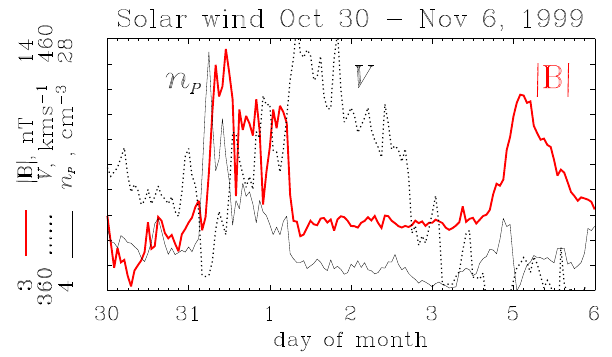
Fig. 4. The co-rotating solar wind plasma stream and interaction re- gion observed by the ACE spacecraft. Alfv´en waves were observed in the stream after the magnetic field magnitude leveled off. The day of month labels are placed at 00:00 UT of each